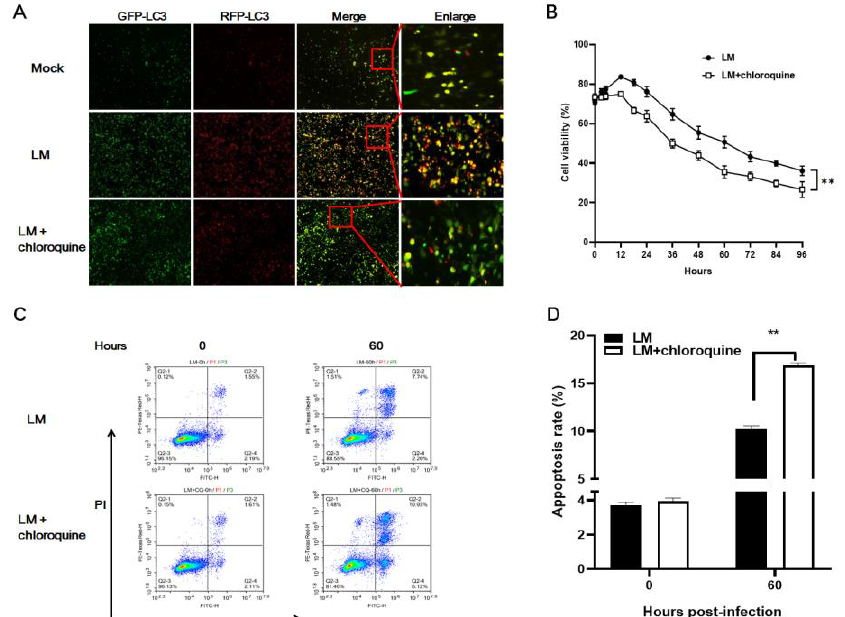
Figure 2. Inhibition of autophagy induced more B16F10 cell death than LM infection alone. ( A ) B16F10 cells were infected with adenovirus expressing GFP-RFP-LC3 for 36 h followed by treatment with LM, CQ, or LM + CQ. Autophagosomes were observed by fluorescence microscopy. Representative images of fluorescent LC3 puncta are shown. Yellow puncta represent phagophores and autophagosomes, and red puncta represent autolysosomes. GFP-LC3, RFP-LC3, merge (magnification, × 40), and enlarge (×100). ( B ) B16F10 cells were infected with LM at an MOI of 100 in the presence or absence of 20 µ M CQ for the indicated time. Cell viability was analyzed by CCK-8 assay. Data are presented as the means ± SD. ( C , D ) B16F10 cells were infected with LM at an MOI of 100 by the action of 20 µ M CQ. Cell death was determined by flow cytometry. Data are presented as the means ± SD (** p < 0.01).